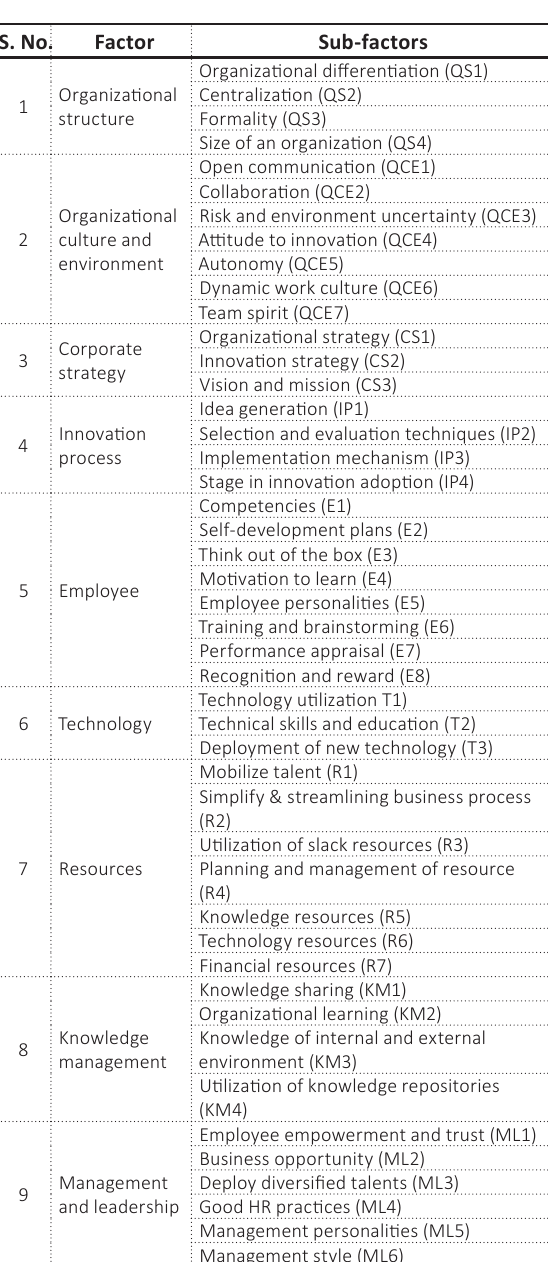
Table 1. Factors and sub-factors identified from the literature